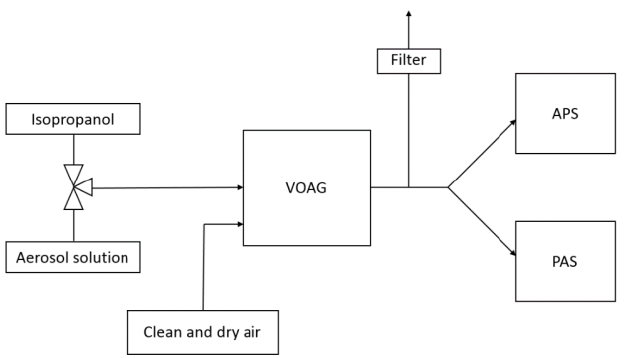
Figure 1. The sampling configuration used in the laboratory experiment. Manually operated three-way valve controlled the isopropanol and aerosol solution feeds.